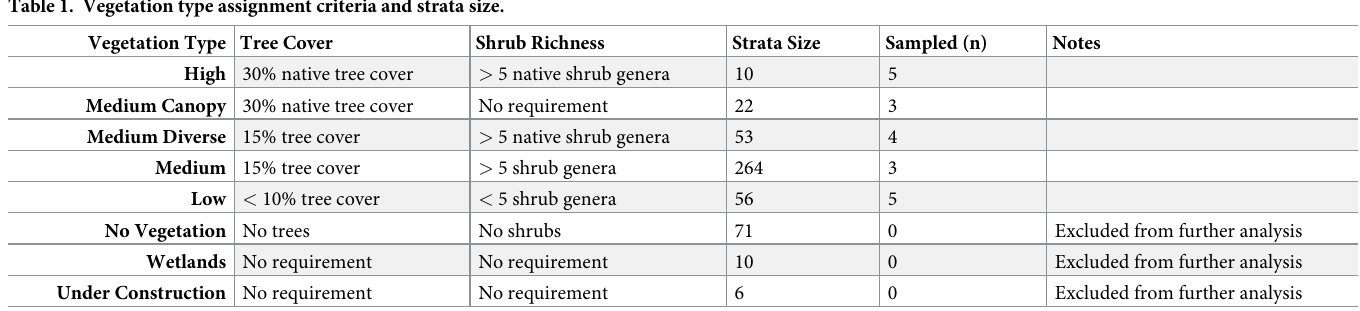
Table 1. Vegetation type assignment criteria and strata